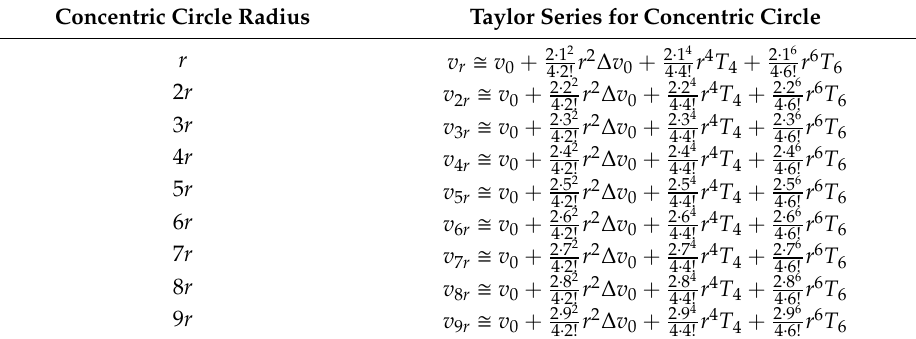
Table 1. Taylor series for concentric circles. Concentric Circle Radius Taylor Series for Concentric Circle